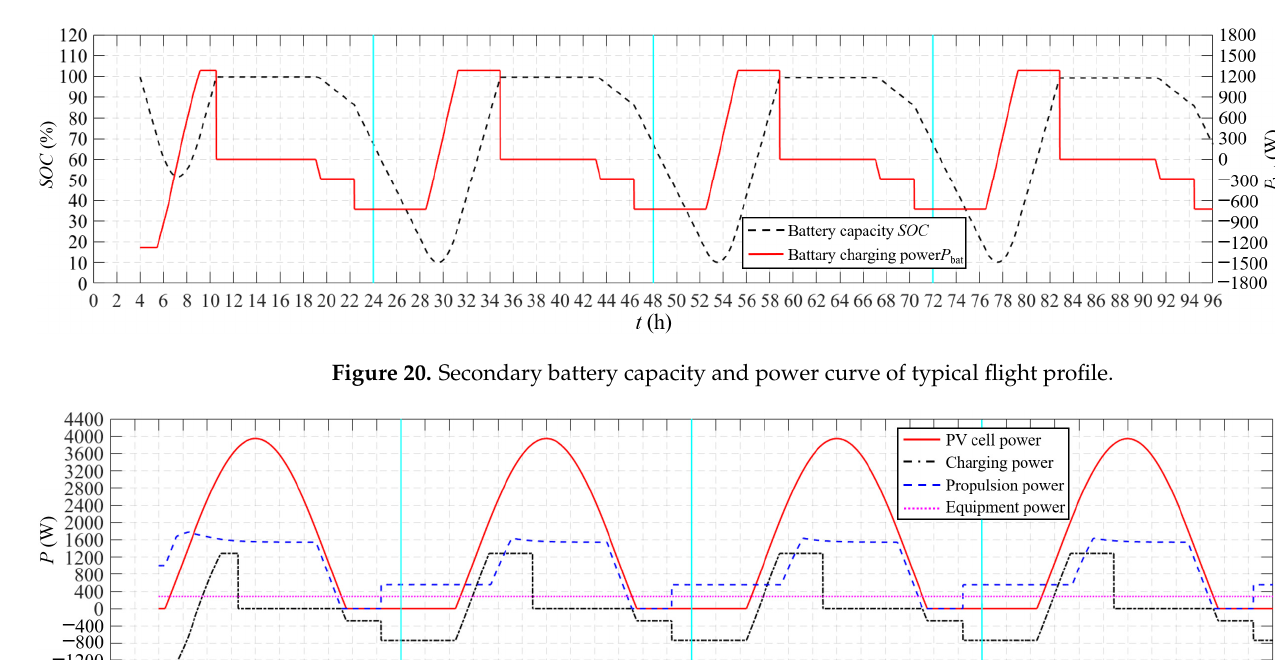
Figure 19. Climb rate of typical flight profile.